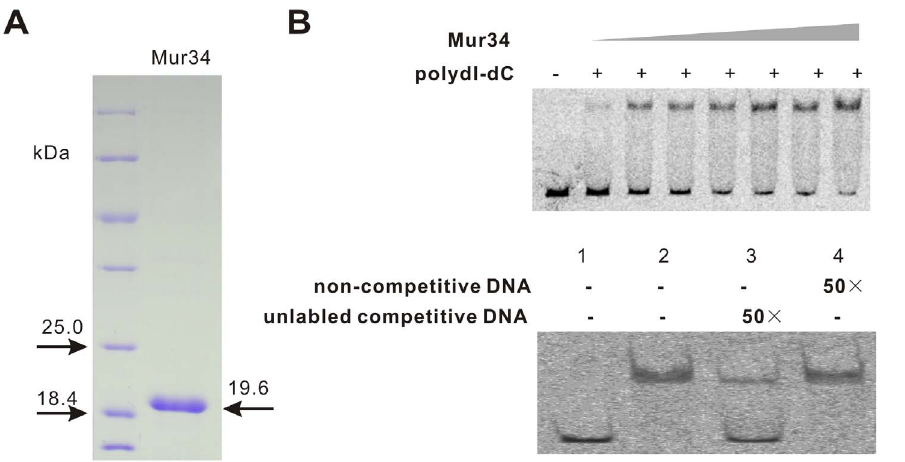
Figure 4. EMSA analysis of His 6 Mur34. (A) SDS-PAGE analysis of His 6 Mur34, the theoretical molecular mass of His 6 Mur34 is 19.6 kDa. The Mur34 protein was loaded into 12% SDS-PAGE for analysis. (B) EMSA analysis of Mur34 and mur33 promoter. For the above figure, 50-fold of poly dI-dC was added to the each reaction system with an increasing amount of Mur34. For the competitive assay (below), lower case of all samples contain 2.6 6 10 2 4 M promoter DNA of mur33 (90-bp specific DNA), for samples 2, 3 and 4, extra 9 6 10 2 6 M His 6 Mur34 was individually contained. Moreover, 50-fold of unlabelled competitive DNA was added to the reaction system (band 3), and 50-fold of unspecific non-competitive DNA to the system (band 4). Band designations, 1, free DNA; 2-4, protein-DNA complexes.